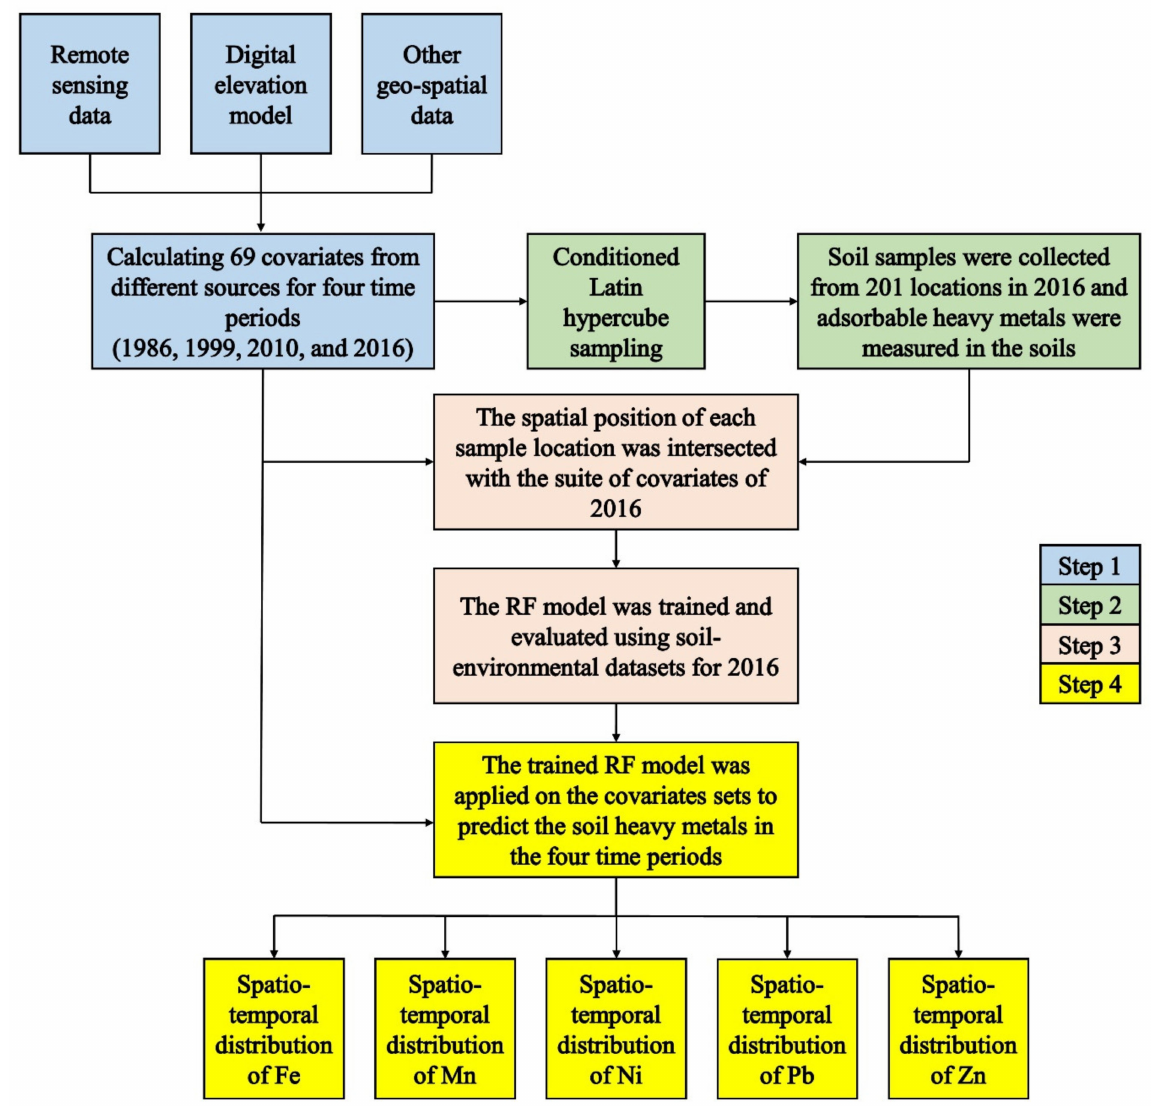
Figure 1. Methodological framework for the spatio-temporal prediction of heavy metals in